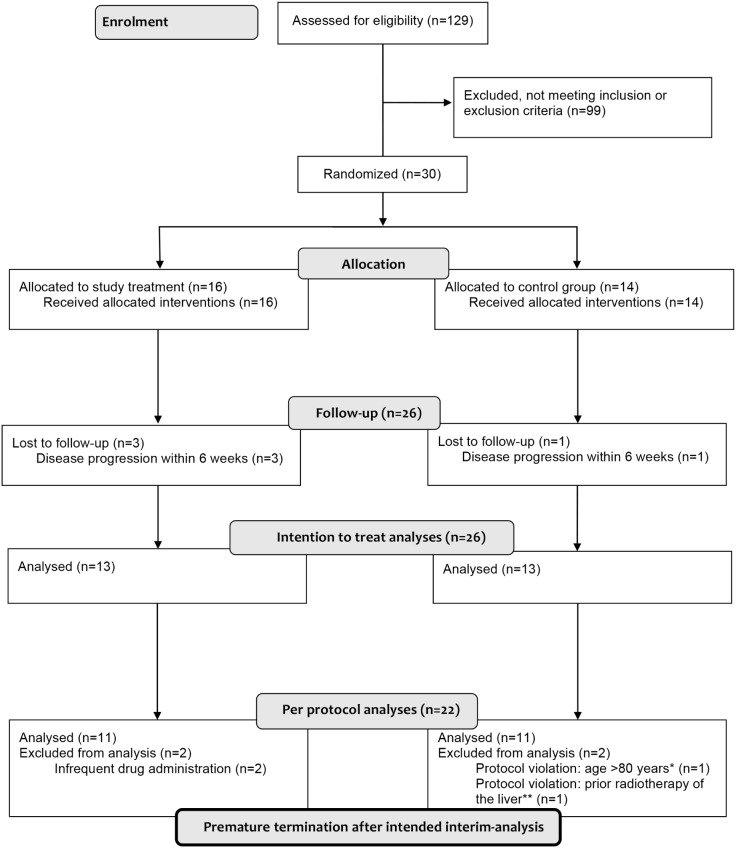
CONSORT-diagram.*Exclusion criterion age was initially disregarded by error in this patient (aged 82). **Exclusion criterion prior radiotherapy was initially disregarded by error in this patient (prior radiotherapy was performed 2 years earlier with location in the contralateral liver lobe).